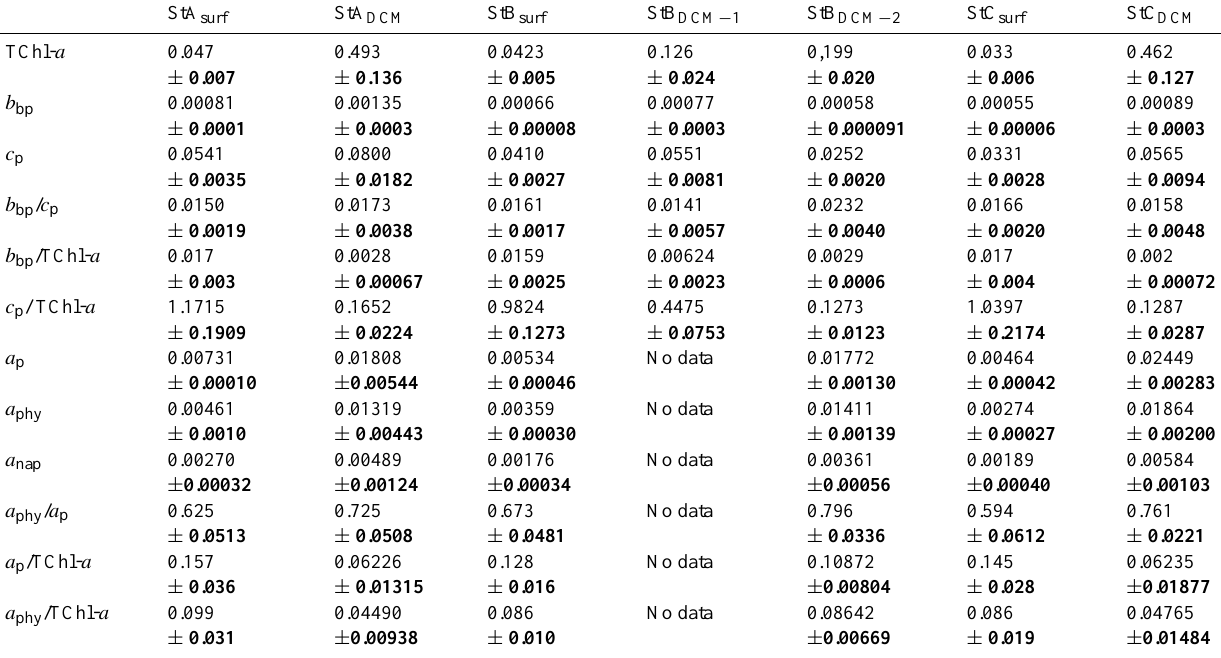
Table 1. General bio-optical characteristics of the surface water and at the deep chlorophyll maximum (DCM) at the long duration stations A, B, and C. The values in standard font and bold represent the mean and standard deviation values, respectively. The particulate backscattering ( b bp ) and attenuation ( c p ) coefficients values are given 650 and 660nm, respectively. The absorption coefficients values are given at 440nm. The subscripts p, phy, and nap stand for particulate, phytoplankton, and non-algal particles,